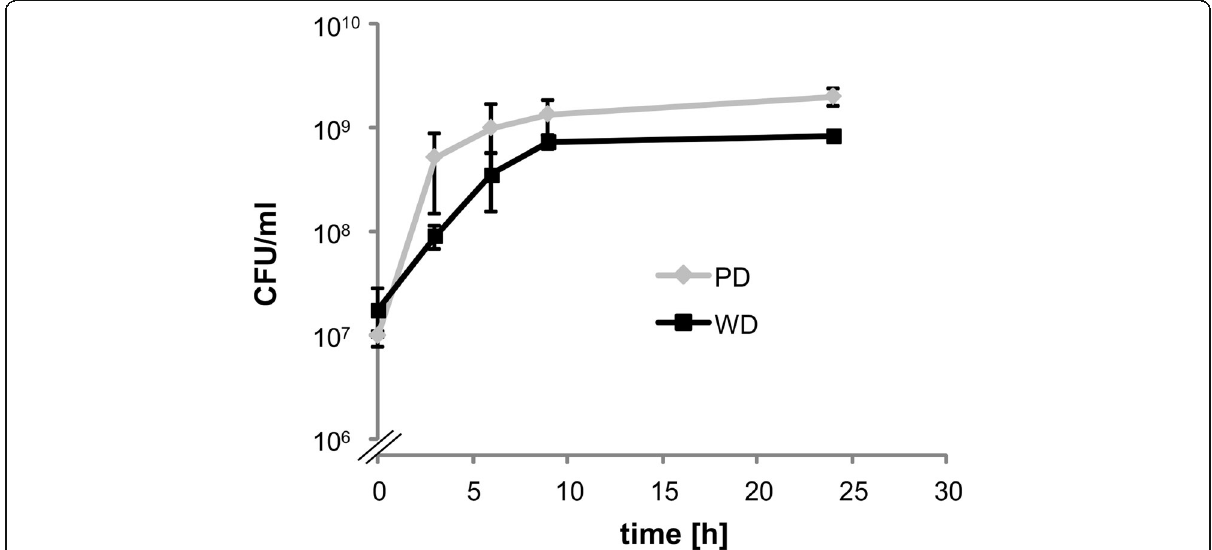
Fig. 2 Growth phenotype of strain ST4/74 Δ invA in medium with PD and WD pellets. The growth behaviour of strain ST4/74 Δ invA was tested in medium with food pellets for PD (gray line) or WD (black line) dissolved in water. The CFU of three biological replicates were determined by plating three aliquots at each time point. Error bars show the standard